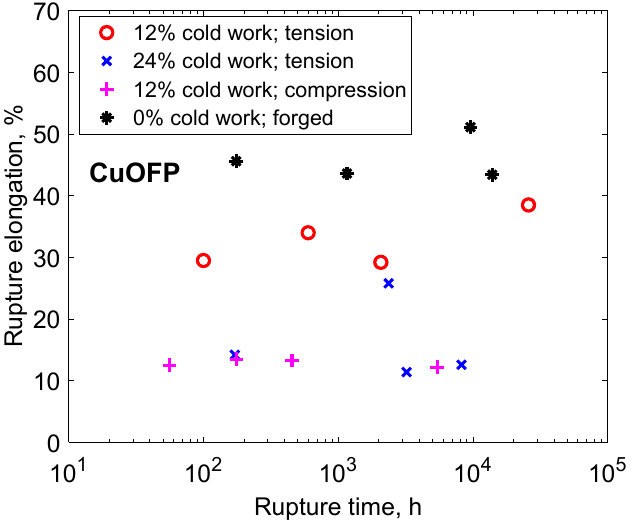
Figure 8. Rupture elongation versus rupture time for 12% and 24% cold deformed Cu-OFP at 75 °C. For comparison, material without cold deformation is included. Experimental data from [3].